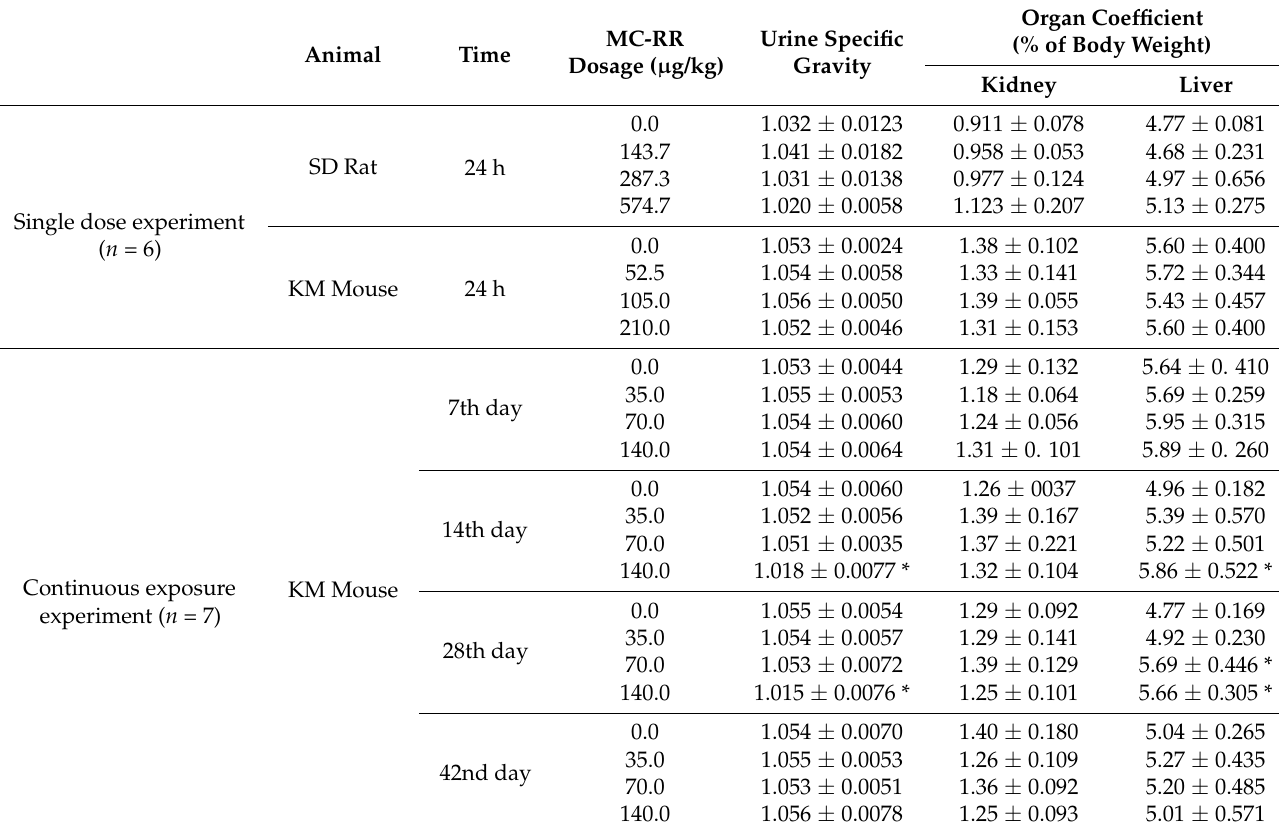
Table 4. Organ coefficient and urine specific gravity of SD rats and KM mice (mean ± SD).